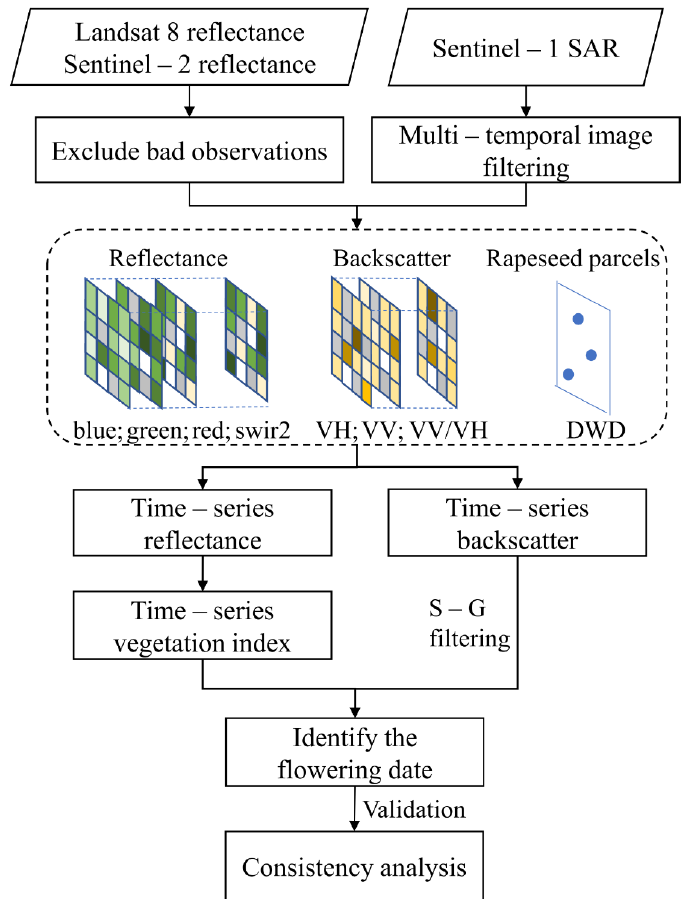
Figure 3. Workflow of monitoring rapeseed flowering phenology in this study. Major modules include (1) data (Landsat 8 and Sentinel-1/2) preprocessing, (2) the extractions of time series of